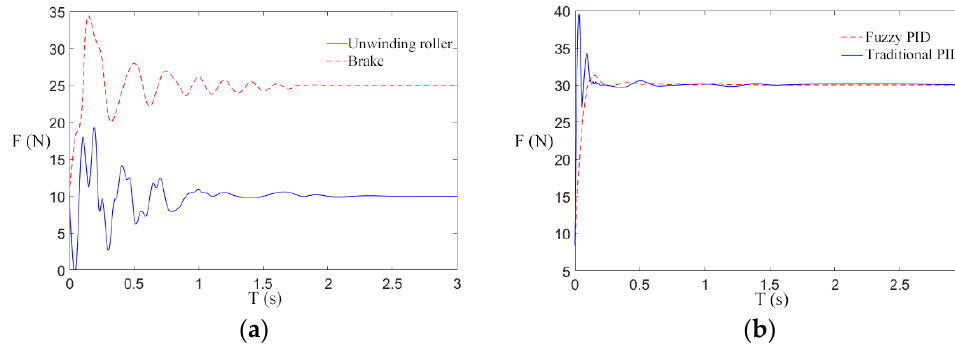
( b ) Figure 14. Tension response at 50 N reference tension. ( a ) Tension of unwinding roller and electro- magnetic brake; ( b ) Tension of take-up roll. In summary, under the action of different reference tensions, the fuzzy control scheme has a better control effect than the traditional scheme on the influence of real-time changes of the radius of the unwinding roller and the rewinding roller on tension, with smaller fluctuation and faster progress to the stable state. In order to further study the effectiveness of the fuzzy control scheme of a trans- former winding machine in eliminating speed interference, step interference of the re- winding speed was introduced after the winding machine was started for 2 s. The param- eters of speed and tension in the simulation experiment are shown in Table 5, and the simulation results are shown in Figures 15–17. In Figures 15a, 16a and 17a, when the winding speed is increased from 0.2 to 0.5 m/s, the sudden increase in the speed causes fluctuations in winding tension. In the traditional